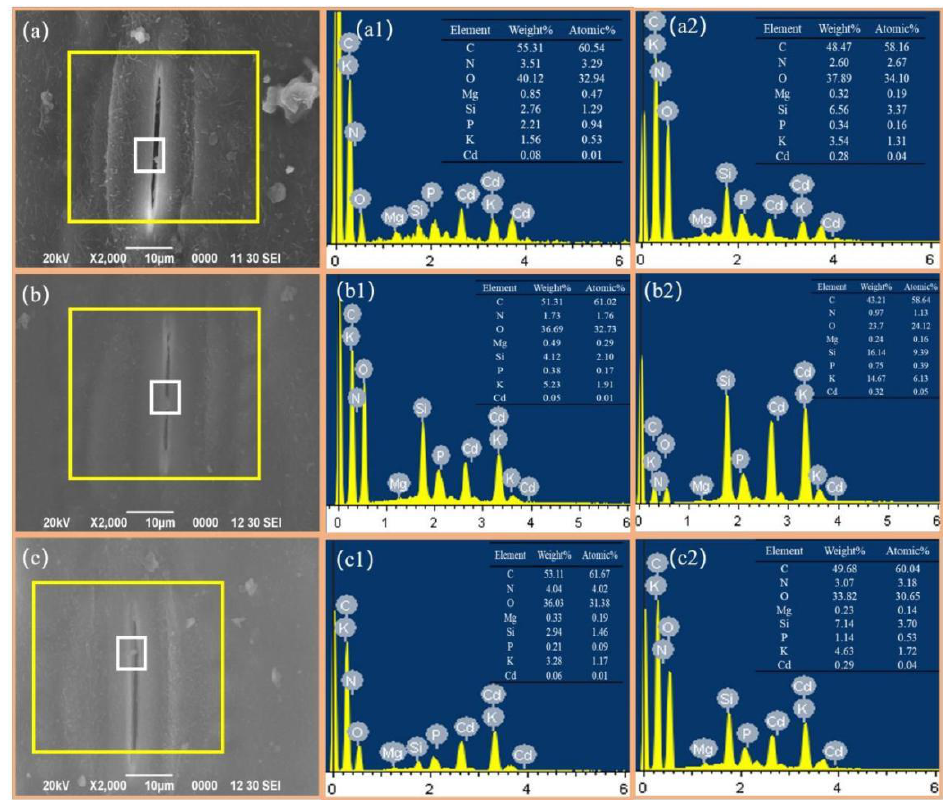
Figure 3. EDS analysis of stomatal surface ( a ) flag leaf, ( b ) the second leaf, ( c ) the third leaf. The scanning area ( a1 , b1 , c1 ) is shown by a yellow wire frame. The scanning area ( a2 , b2 , c2 ) is shown by a white wire frame. The magnification of leaves is 1000×, the magnification of husk and awn is 1000×.